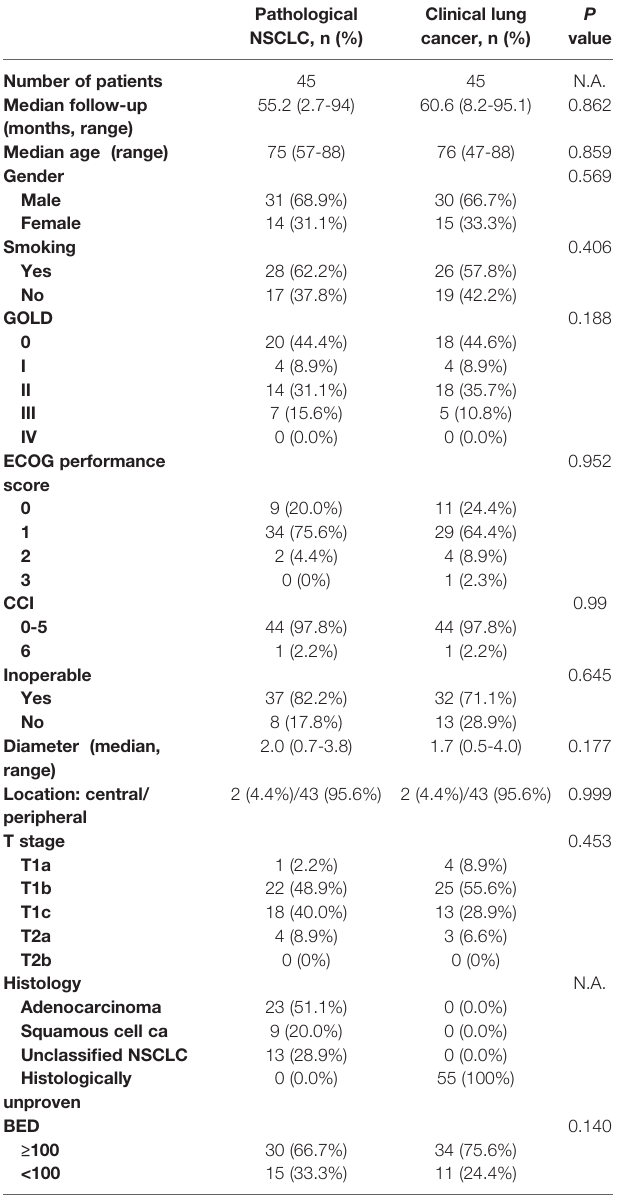
TABLE 2 | Characteristics of propensity score matched